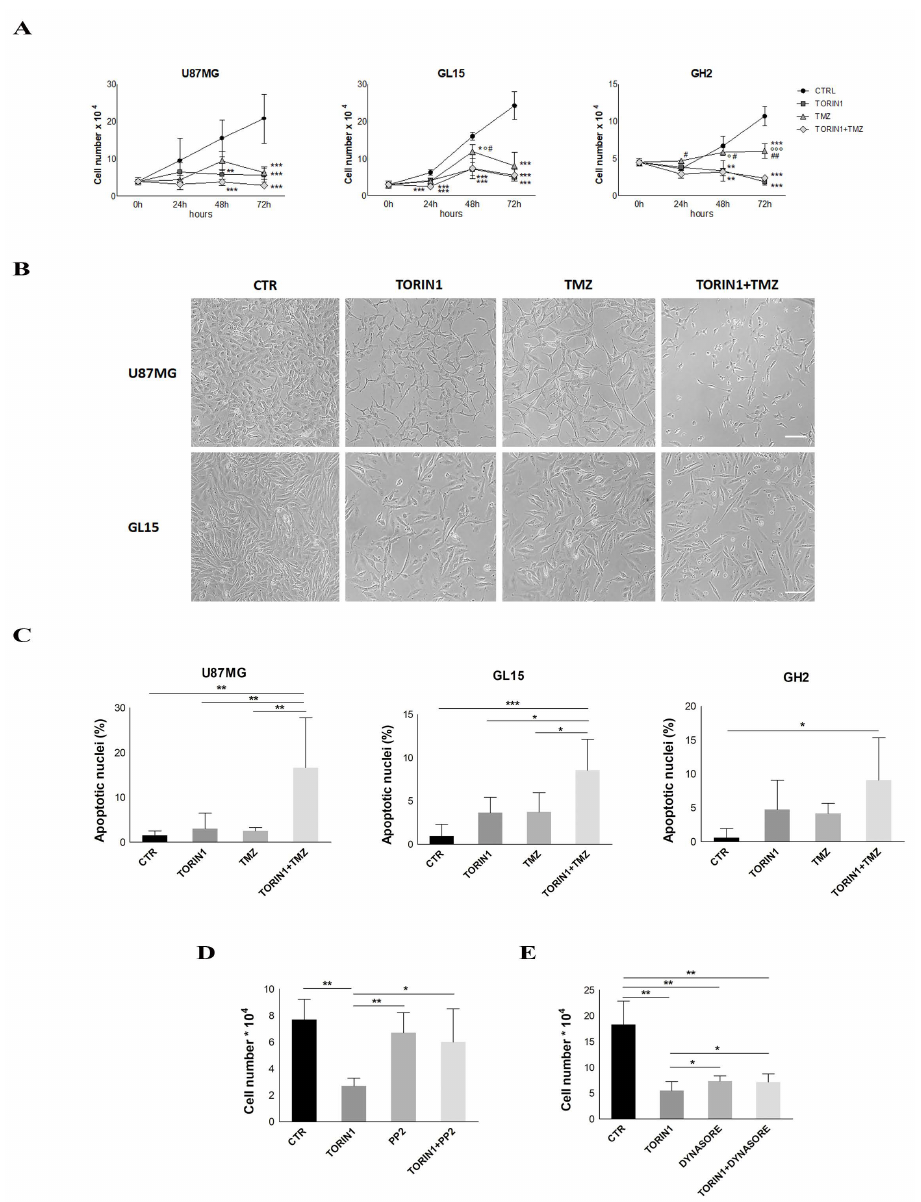
Figure 7. mTOR inhibition leads to cell proliferation arrest. ( A ) U87MG, GL15 and GH2 cells were cultured in complete DMEM (CTR) or in the presence of 250 nM Torin1 (TORIN1) or 500 µ M Temozolomide (TMZ) or both. At the indicated time points, cells were trypsinised and counted in a Newbauer chamber. The graph represents the mean ± Standard Error of the Mean (SEM) of three di ff erent experiments. Statistical significance: * indicates significance vs. Ctr; # indicates significance vs. Torin1 + TMZ; ◦ indicates significance vs. Torin1. ** p < 0.01 *** p ≤ 0.001 Two-way ANOVA. ( B ) Pictures of the cells in ( A ) were taken at 72 h of the indicated treatments. Scale bar: 100 µ m ( C ) U87MG, GL15 and GH2 cells were cultured in complete DMEM (CTR) or in the presence of 250 nM Torin1 (TORIN1) or 500 µ M TMZ or both Torin1 and TMZ for 72 h. Nuclei were then stained with DAPI and counted under fluorescence microscope (20 × objective). 10 fields per each condition were counted. The graphs represent the mean ± SD of three di ff erent experiments. * p < 0.05, ** p < 0.01, *** p ≤ 0.001 One-way ANOVA; ( D , E ) U87MG cells were incubated with Torin1 in the presence or absence of 20 µ M PP2 ( D ) or in the presence of 100 µ M Dynasore ( E ) for 48 h before cell counting in a Newbauer chamber. The graphs represent the mean ± SD of three di ff erent experiments. Statistical significance: * p < 0.05, ** p < 0.01 One-way